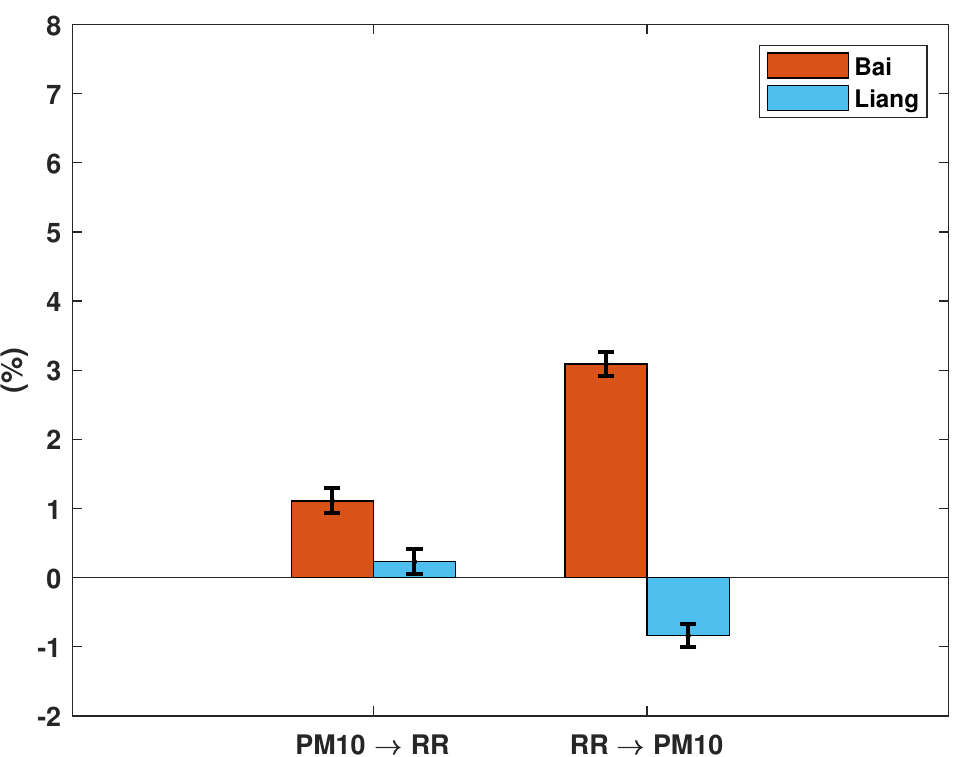
Figure 4. Cross map between between PM 10 and RR over 11 years.